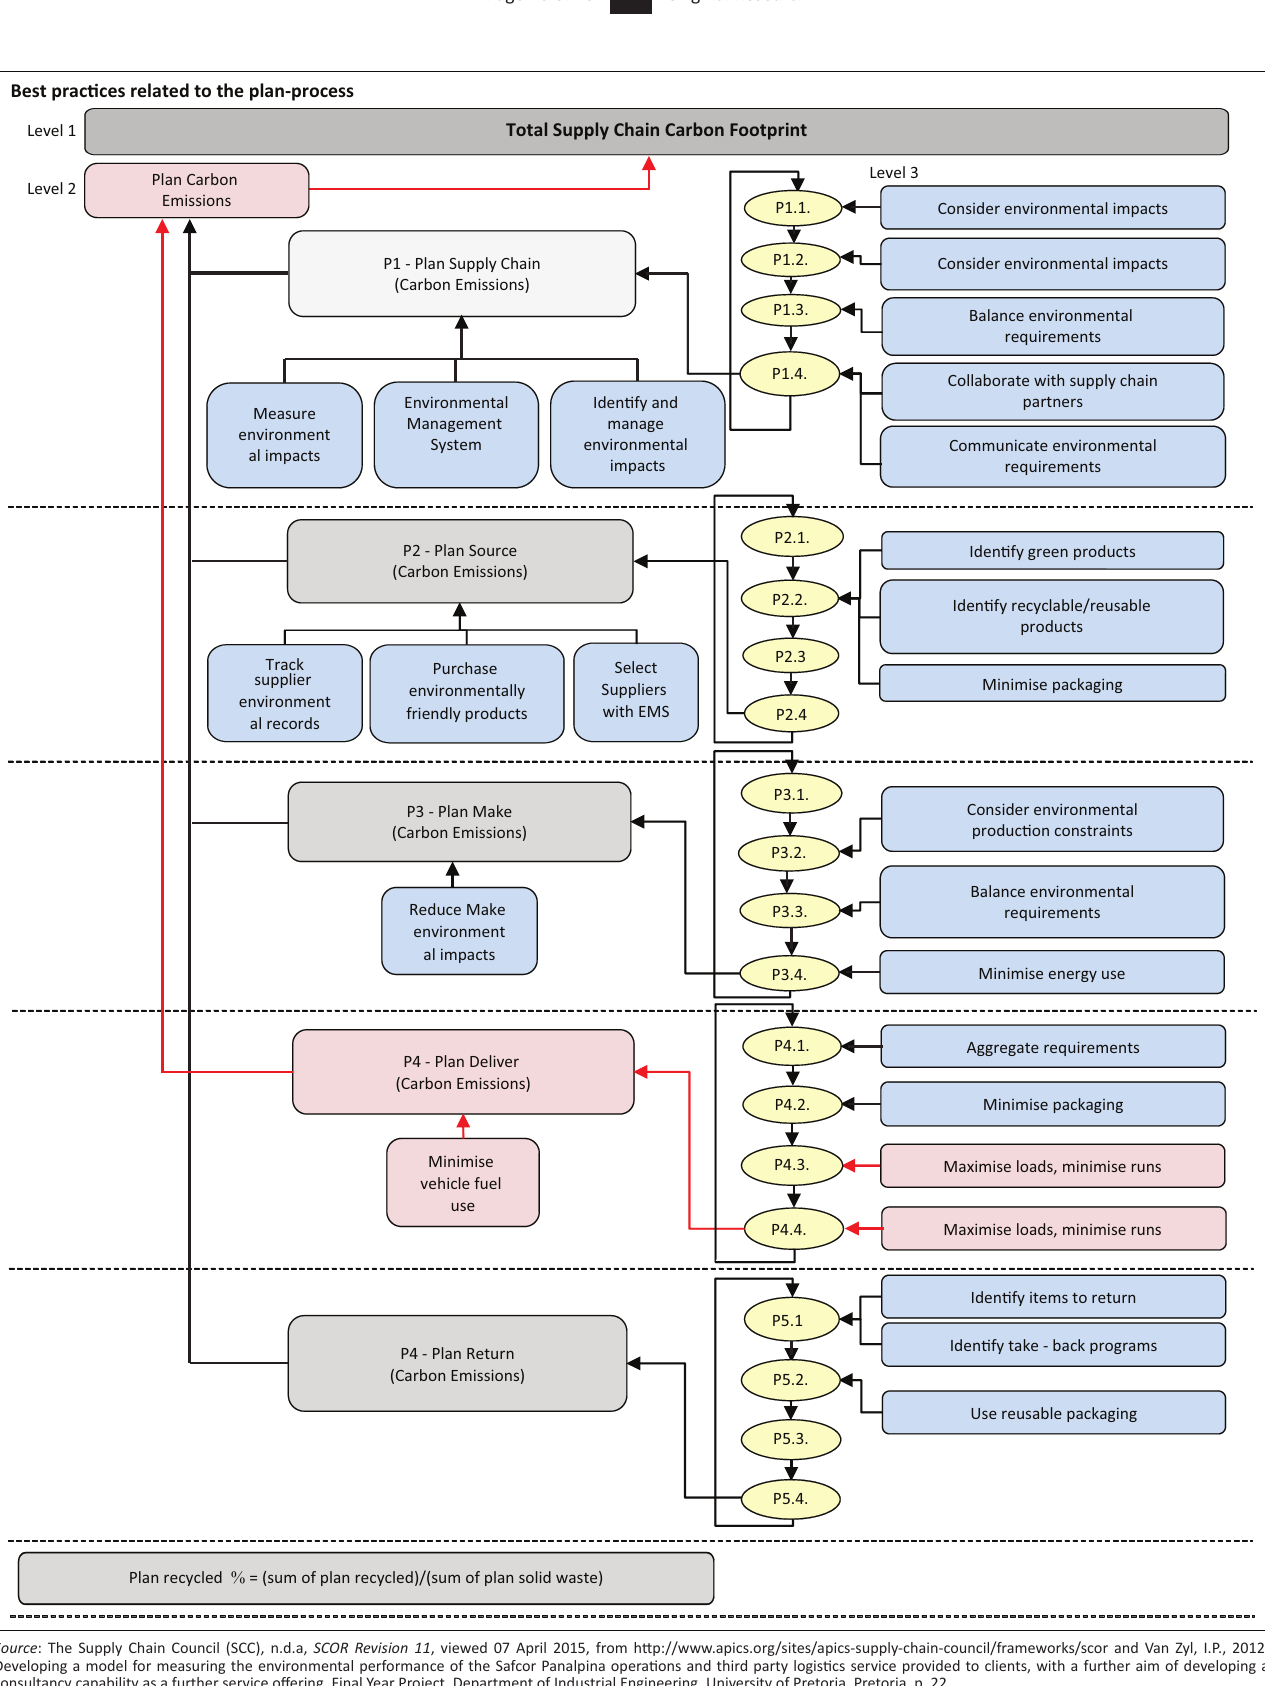
FIGURE 3: Best practices related to the plan process using Green supply chain operations